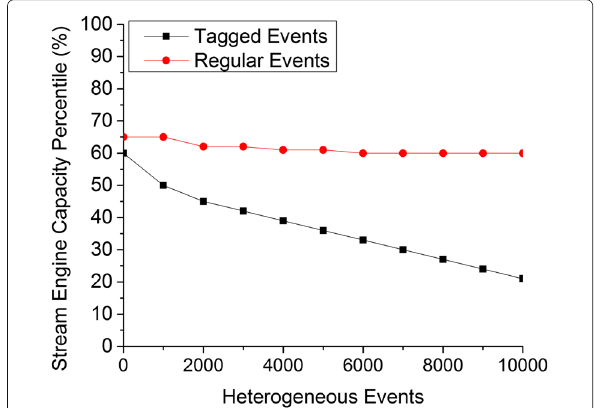
Fig. 7 Heterogeneous Events Processing